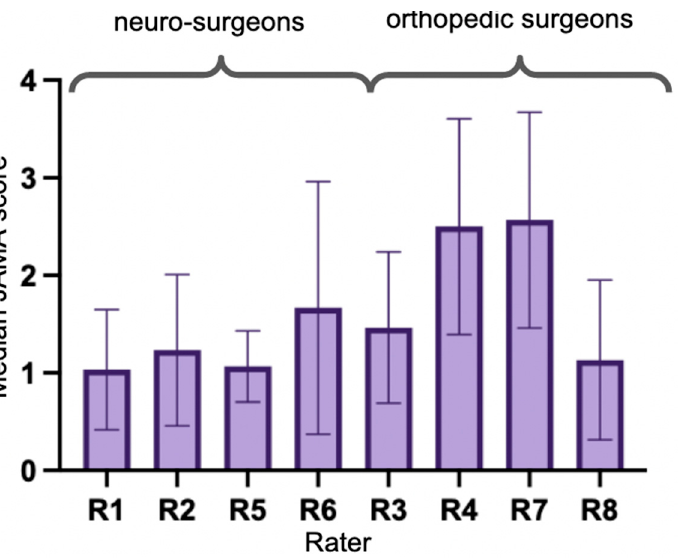
Figure 4. Median JAMA scores for each rater (R1-8). R4 and R7 assigned significantly higher JAMA scores than the others. Orthopedic surgeons assigned significantly higher JAMA scores in total.